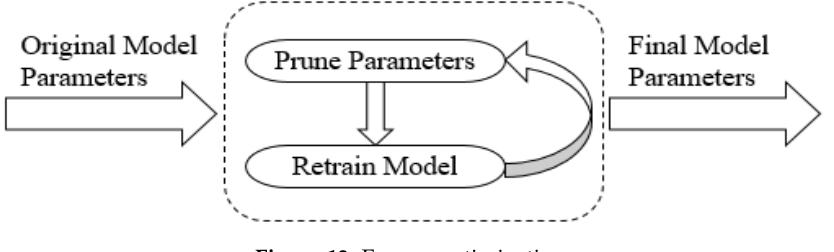
Figure 13. Energy optimization.